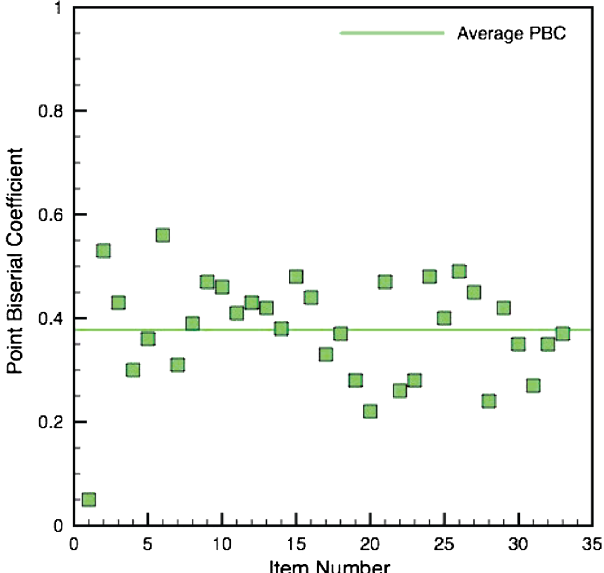
FIG. 2. PBC for each item. The solid line represents the mean value for all